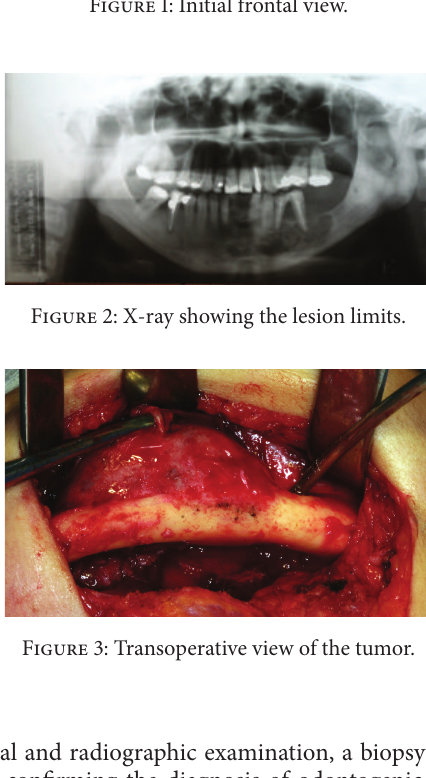
Figure 1: Initial frontal view.